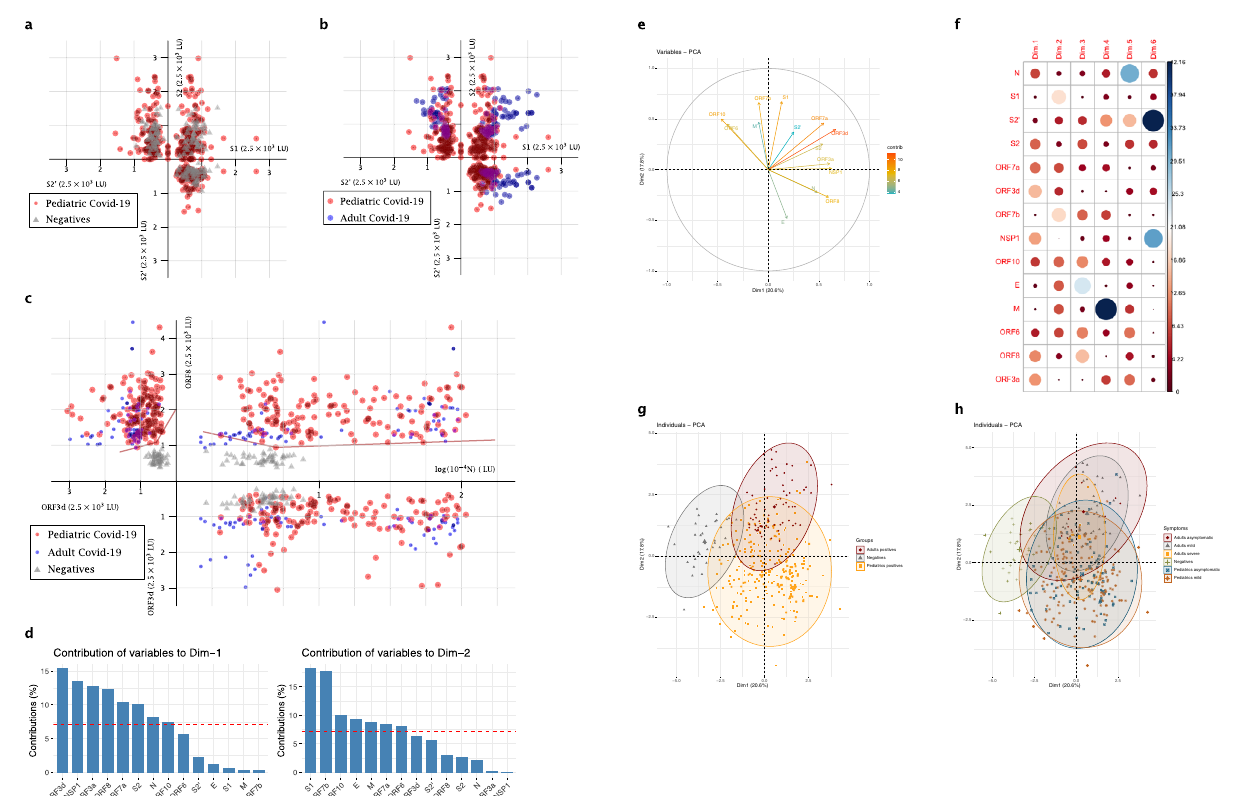
Fig. 3 Representation of the pediatric COVID-19 population as a cluster of points for relevant antibody combinations and principal component analysis (PCA). a , b Cluster representation of S1, S2 ′ , S2 antibodies combination. a The pediatric COVID-19 population versus the negative population, b the pediatric COVID-19 population versus the adult COVID-19 population (for the sake of clarity, the three populations were not represented on the same graph here). c Cluster representation of N, ORF3d, ORF8 antibodies combination, for the pediatric COVID-19 population versus the adult COVID-19 population and the negative population. Samples are represented according to their values of SARS-CoV-2 individual LIPS antibodies as (x, y, z) in the space. For the sake of clarity, only n = 144 pediatric COVID-19 (red), n = 71 adult COVID-19 (blue), and n = 48 negative (gray) samples are represented ( a – c ). d – f PCA of 14 antibodies analyzed in COVID-19 pediatric patients. Dim1 explains 20.6% of the variation, while Dim2 explains 17.7% of the variation. d Contribution of variables on dimensions 1 and 2. The red dashed line on the graph above indicates the expected average contribution. e Correlation circle and contributions. The scale of contributions is indicated (right). f Summary of contribution of variables on the different dimensions. g , h Factorial plots of PCA on dimensions 1 and 2. The plot is colored by sample types (Adults positives, Pediatrics positives, negative controls) ( g ), the largest point in shape in each group is the group mean point (circle is for Adult positives, squares for Pediatric positives, triangle for Negative controls) or by symptoms ( h